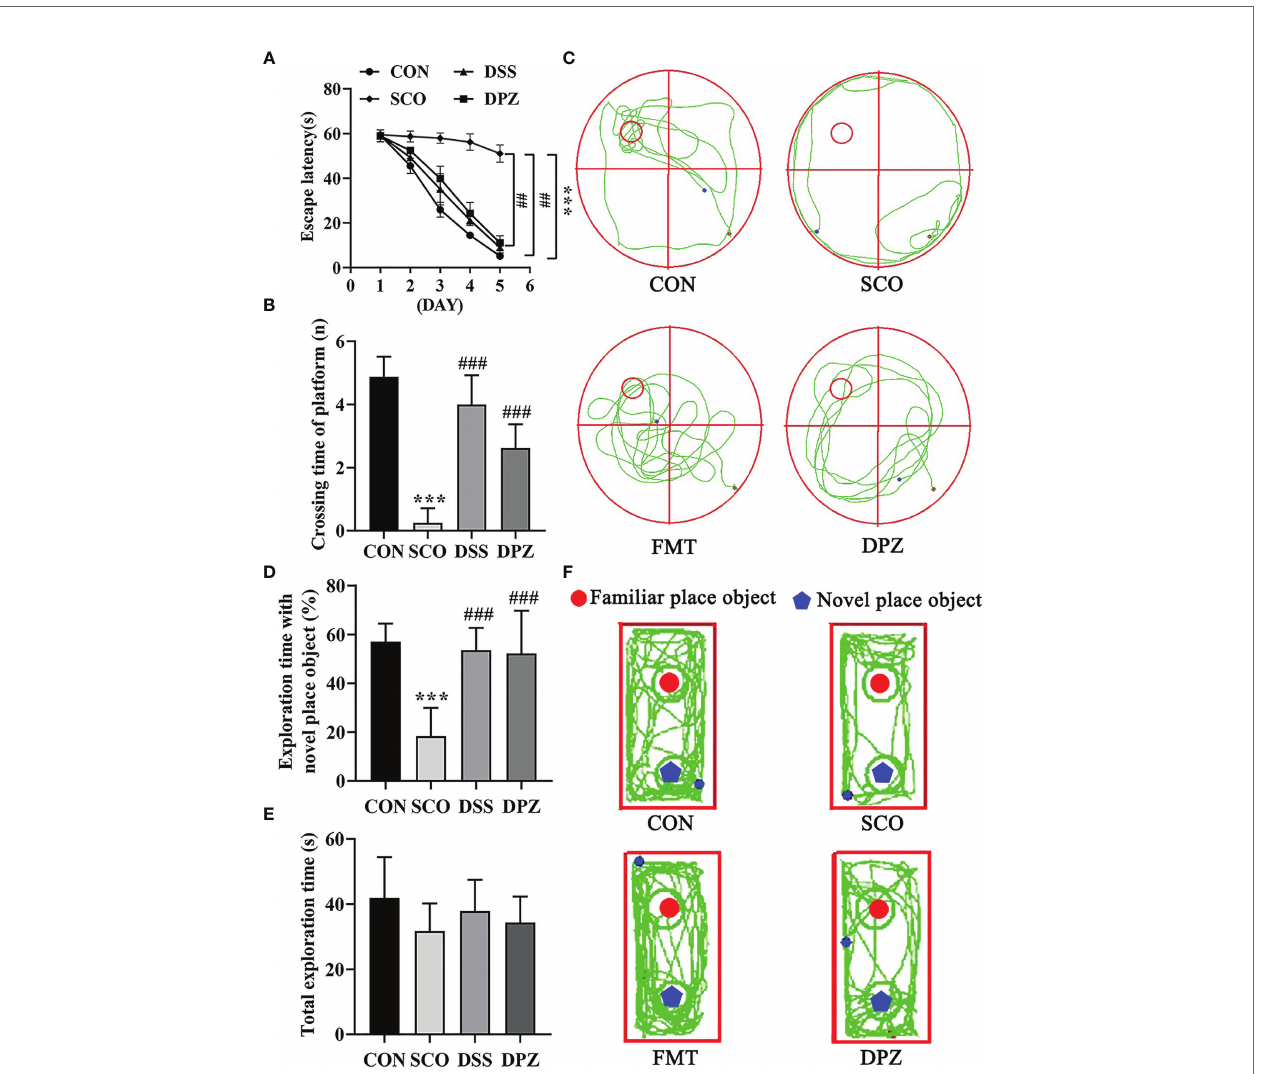
FIGURE 2 | Evaluation of spatial learning and memory performance of CON, SCO, DSS, and DPZ 4 groups using the Morris water maze test and novel object recognition at week 2 after the commencement of their respective diets (n=8-10). For the (A – C) MWM test analysis, we see the following: (A) the escape latency time to reach the hidden platform during training days; (B) the number of entries in the platform zone during the probe trial; and (C) the representative track plots of 4 groups. For the (D – F) NOR analysis, we see the following: (D) the percentage of time spent with the object in the novel place to the total object exploration time; (E) the total object exploration time; and (F) the representative track plots of 4 groups: ## p < 0.01, *** p < 0.001 vs. CON, ### p < 0.001 vs.